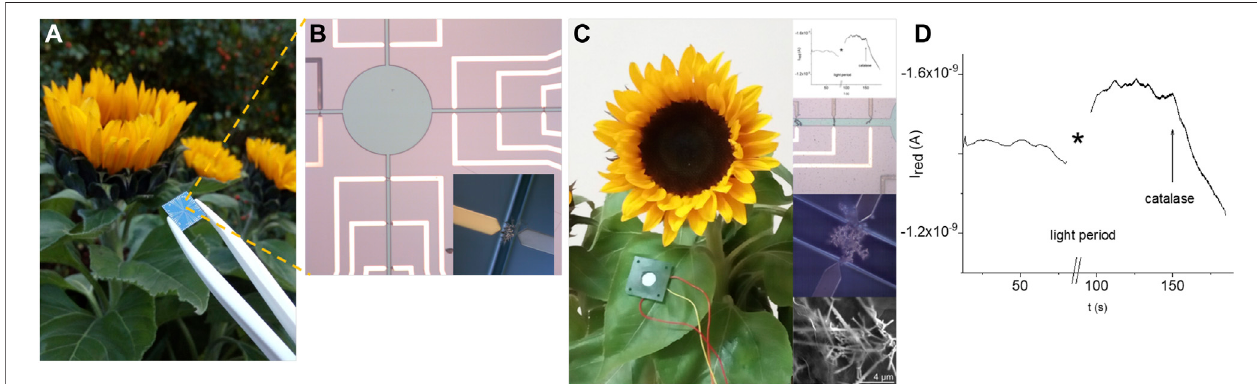
FIGURE 9 | Feasibility of the real time in vivo monitoring of the hydrogen peroxide reduction current in a cut leaf surface of the sun fl ower using an electrochemical sensorsystem:actualimageofachipincomparisonwithasun fl ower (A) ,areaofthesensorsystemwithelectrodesandopening(circleandchannels)forthecontactwith liquid media (insert displays an electrode in the open channel) (B) , example of the positioning of the electrochemical system with the amperometric response before irradiation with light, after irradiation with light, and the addition of catalase (inserts show fragments of the electrochemical system and amperometric measurements) (C,D)